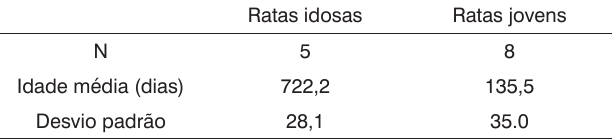
Tabela 1. Idade das ratas segundo os grupos.